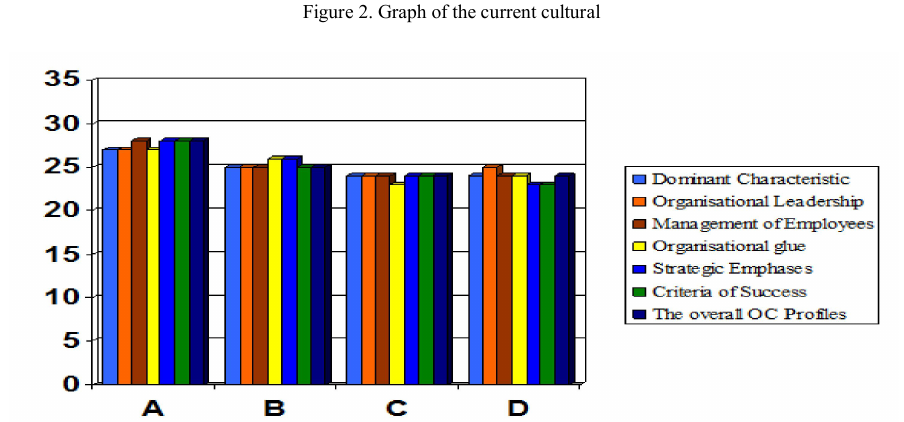
Figure 2. Graph of the current cultural